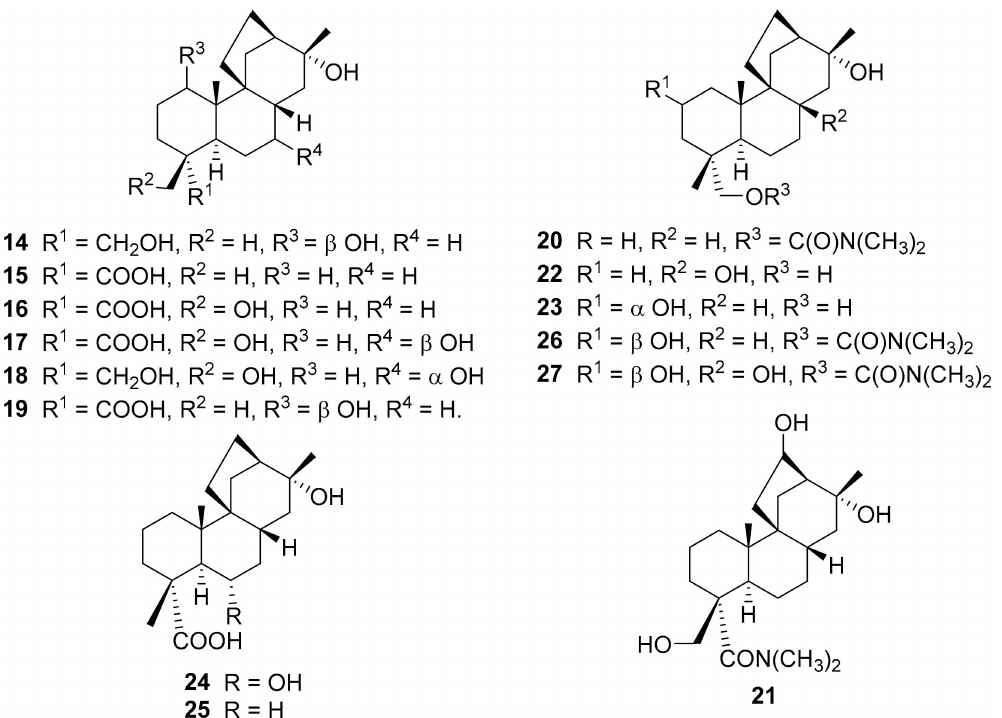
Figure 6. Metabolites obtained by the action of several fungi on ( + )-stemarin ( 1 ) and